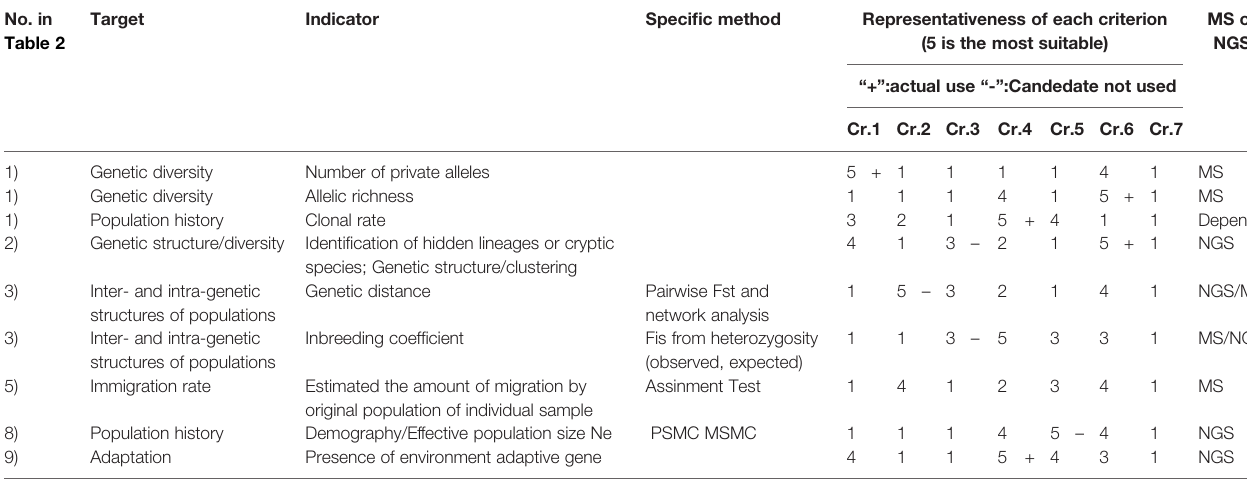
TABLE 3 | Considered indicators and representativeness of each